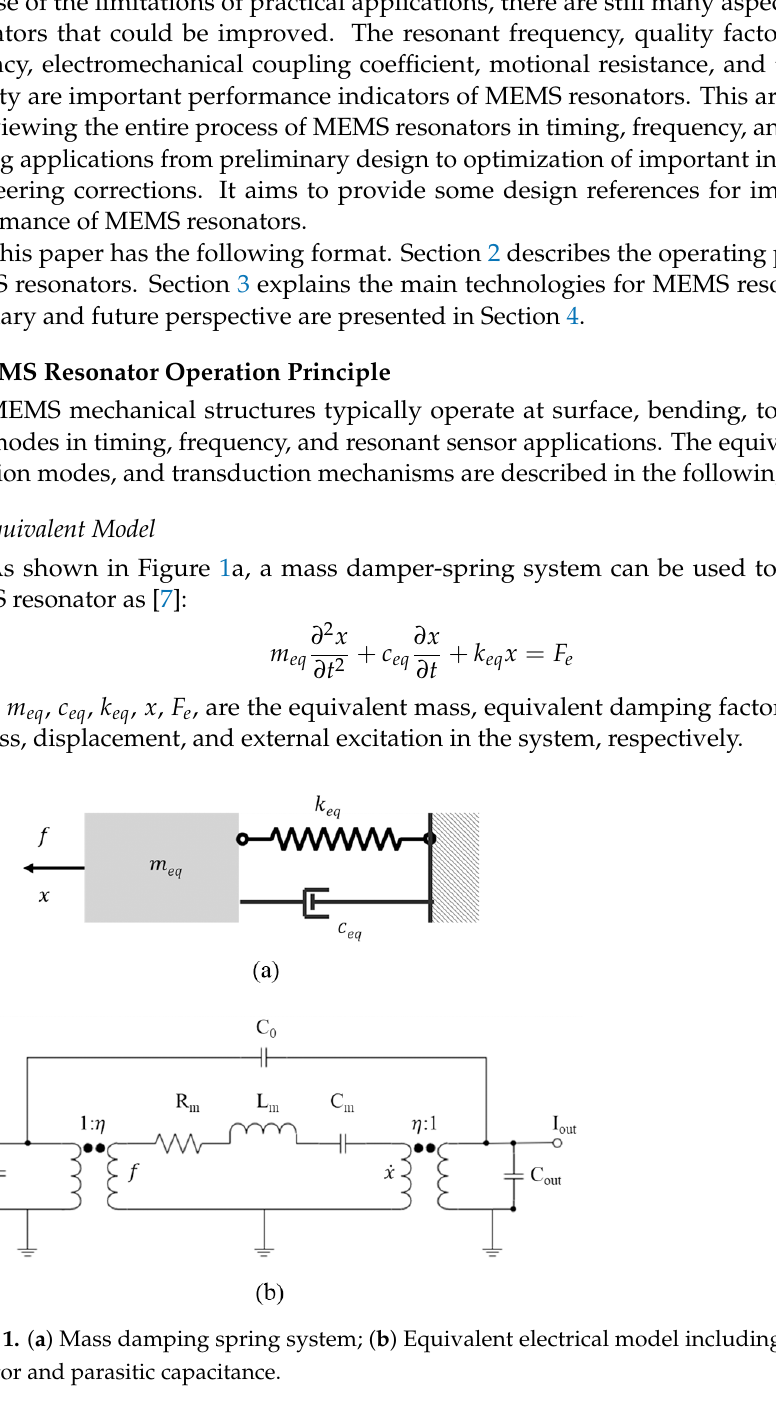
Figure 2. Diagrams of flexural modes ( a – d ) and bulk modes ( e )-( i ): ( a ) Single-ended fixed out-of- plane mode; ( b ) Double-ended fixed out-of-plane mode; ( c ) Double ended tuning forks (DETF) in- plane mode; ( d ) Above-membrane out-of-plane mode; ( e ) Length extension (LE) mode; ( f ) Width expansion (WE) mode; ( g ) Radial breathing mode; ( h ) Lamé mode; ( i ) Wine-glass mode, or face- shear (FS) mode when the resonator is rectangular.